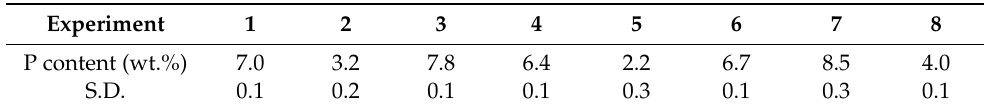
Table 2. Phosphorous content in the coatings obtained from L 8 experiments. “S.D.” stands for standard